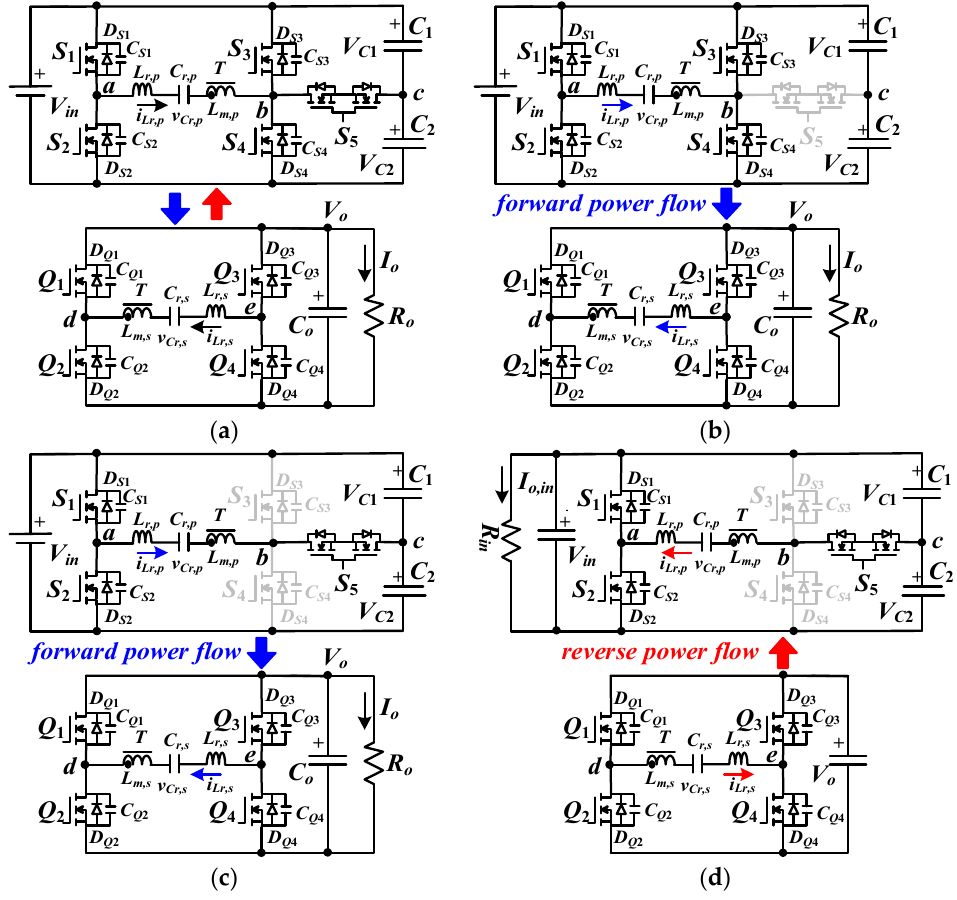
Figure 5. Proposed bidirectional resonant converter: ( a ) circuit configuration, ( b ) equivalent circuit under forward power flow and low input voltage range, ( c ) equivalent circuit under forward power flow and high input voltage range, ( d ) equivalent circuit under reverse power flow operation. Table 1. Comparisons between the proposed bidirectional resonant converter, conventional CLLC resonant converter and dual active bridge converter.